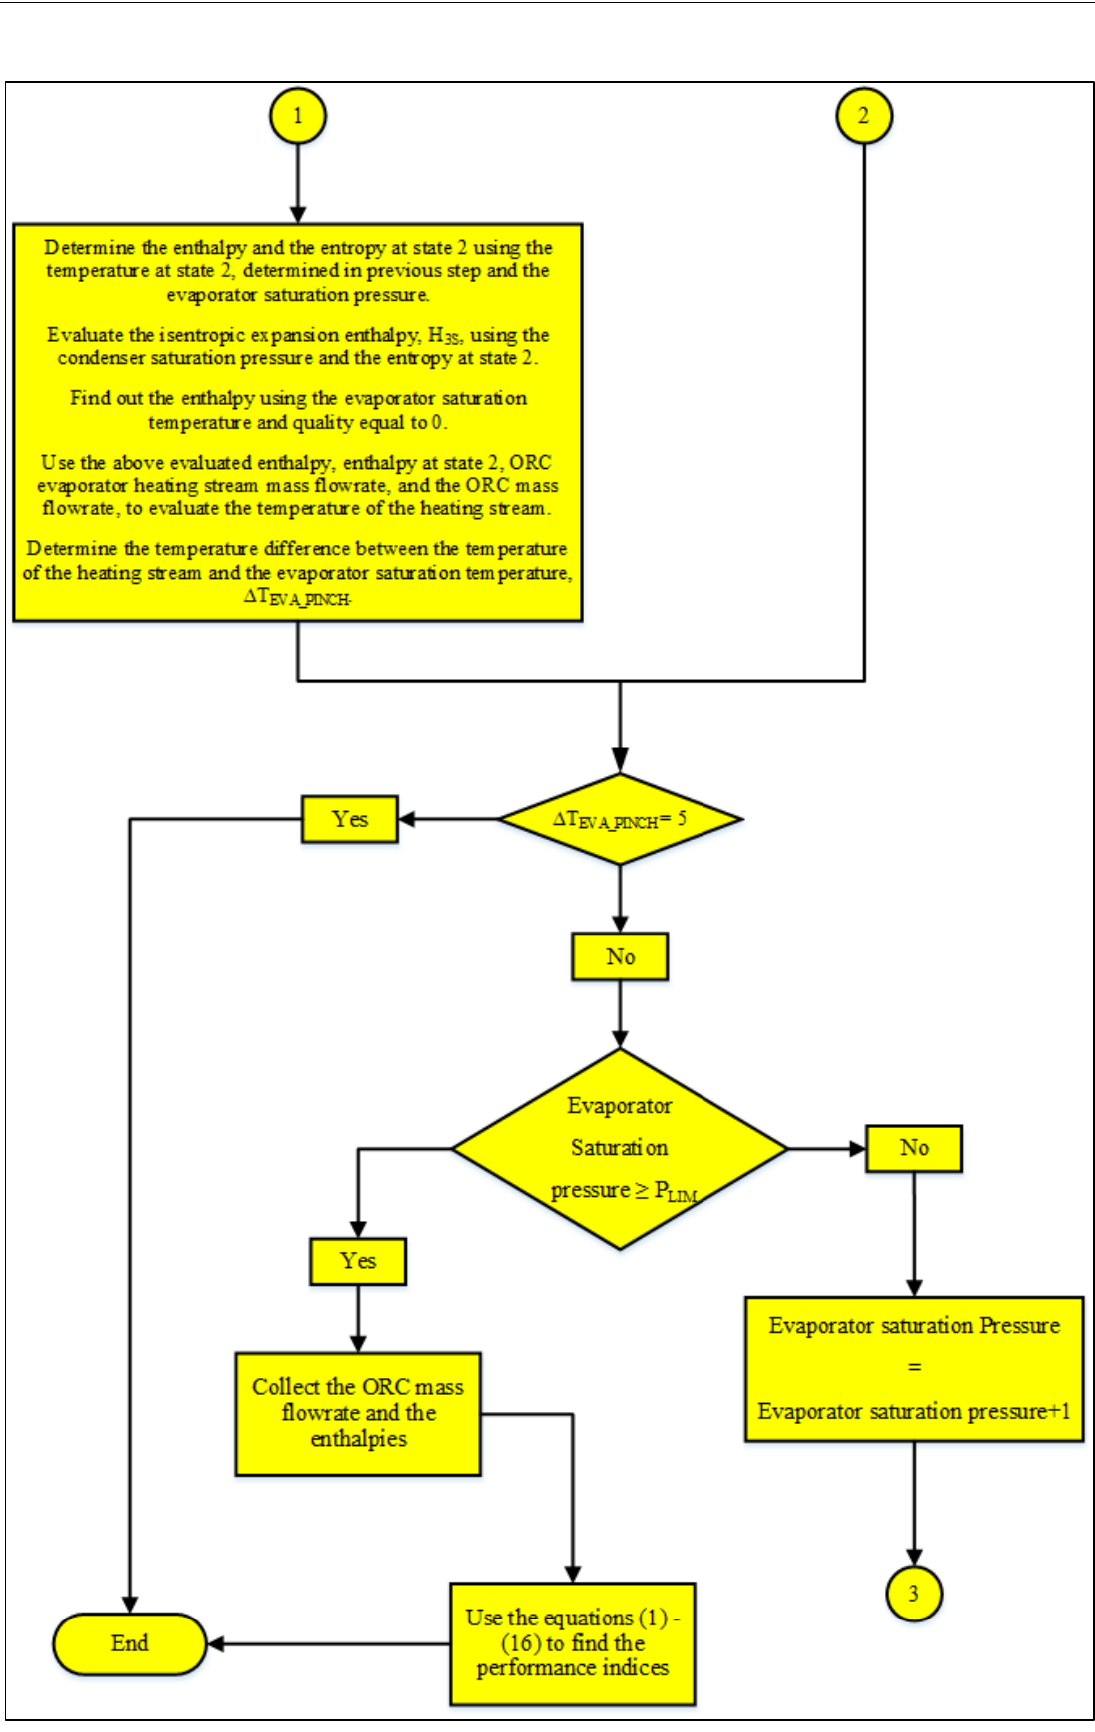
Figure 5. Flowchart for acquiring the ORC state properties and mass flow rate.